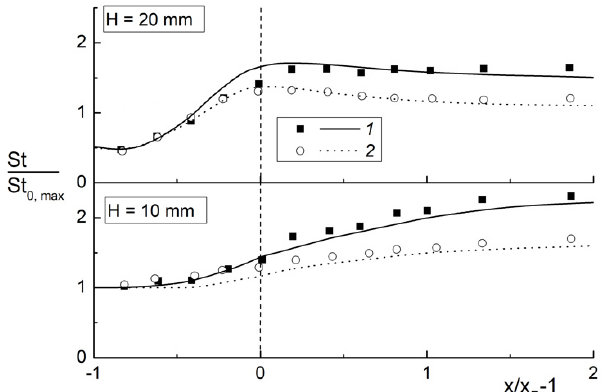
Figure 13. Heat transfer enhancement ratio St/St 0,max in the gas-droplets flow behind the backward- facing step for H = 10 and 20 mm. Symbols are the results of experiments of [16], lines are the au- thor’s simulations. Um 1 = 10 m/s, Re H = Um 1 H / ν = (0.53 and 1.10) × 10 4 , d 1 = 60 μ m, M L 1 = 0.04. 1: T W = 308 K; 2: 338